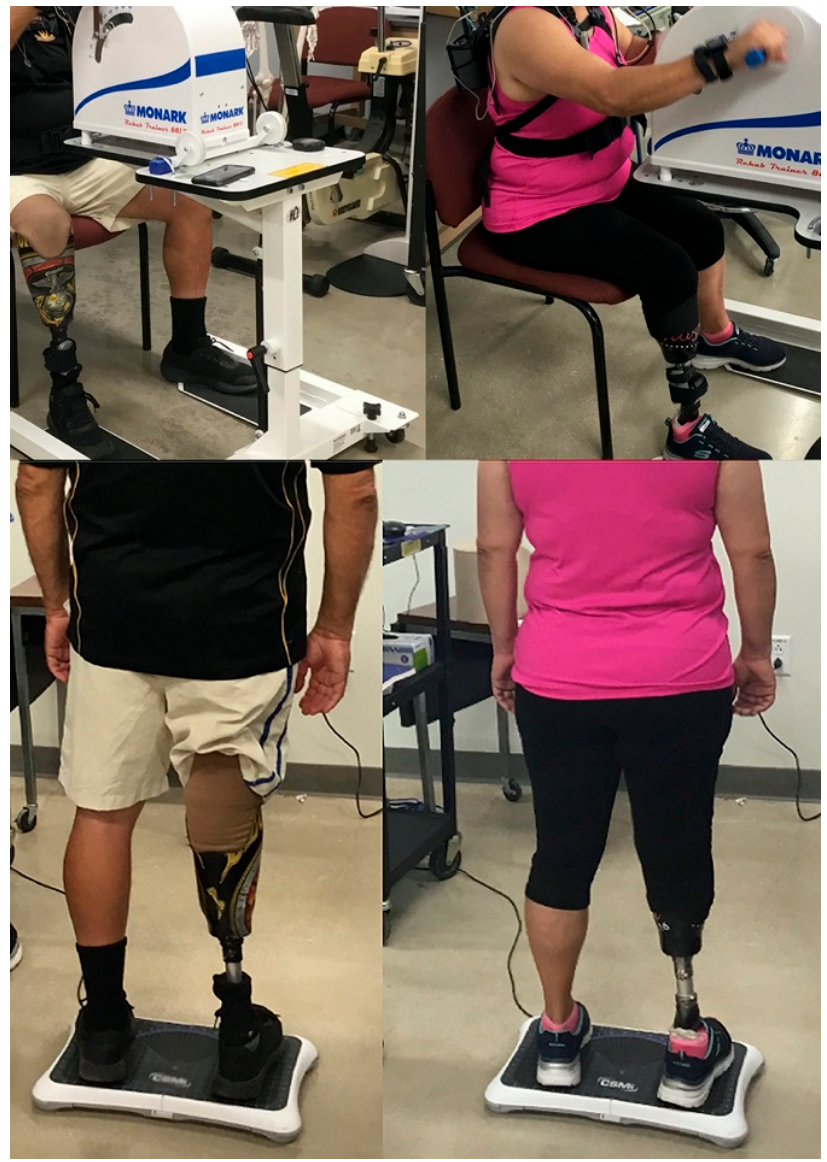
Figure 1. Example setup for the balance and arm crank exercise assessment .